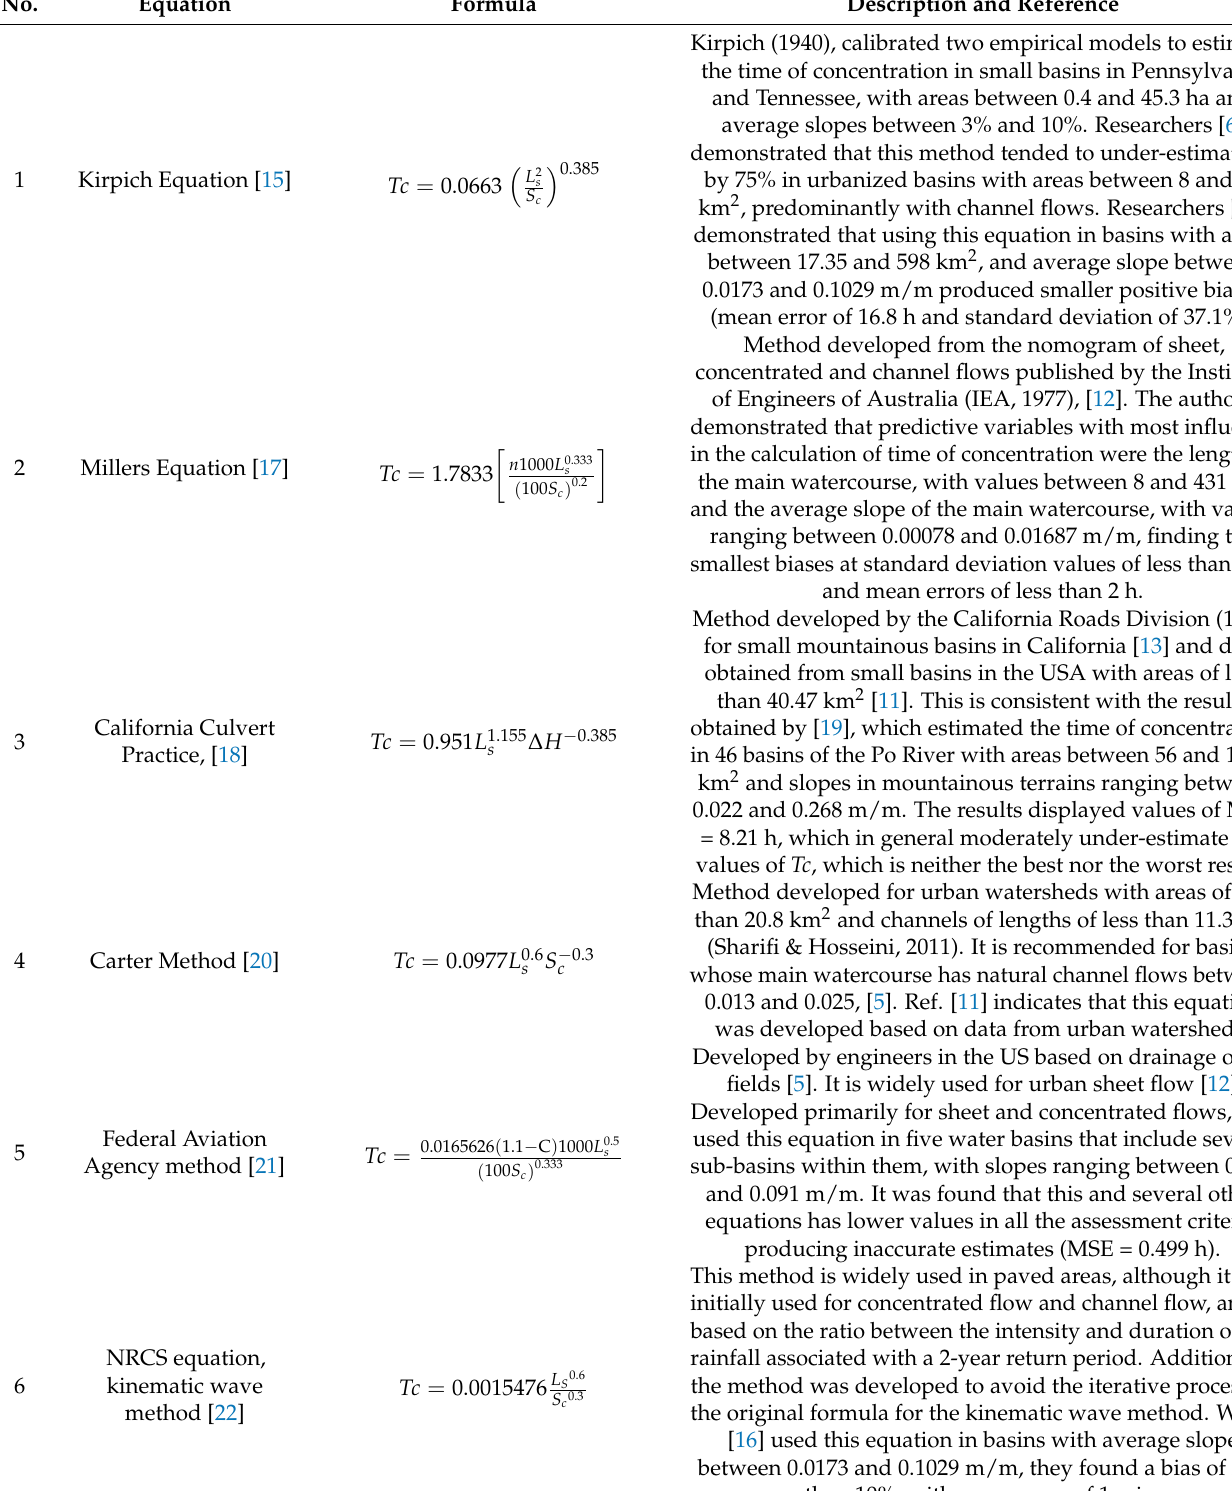
Table 2. Methods to be compared to the baseline